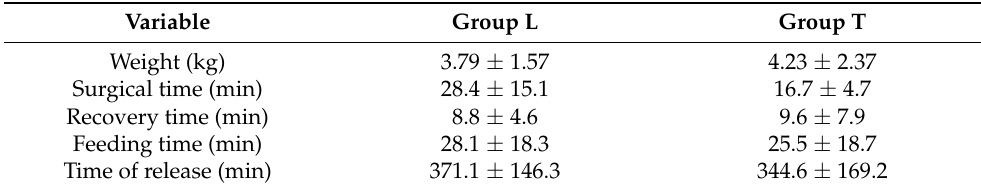
Table 1. Results regarding weight, surgical time, recovery time, feeding time and time of release in Group L and Group T, reported as Mean ±